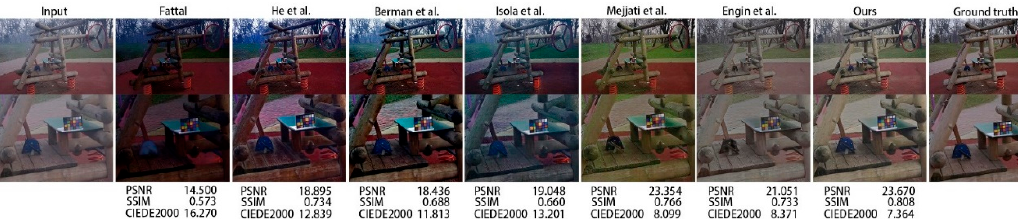
Figure 9. Translation results using our method and other methods for haze-free images [3,9,11,12,20,26].